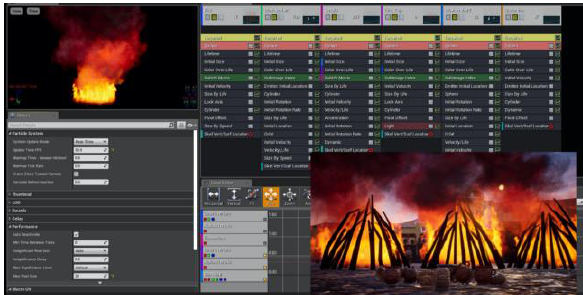
Figure. 3. Process of creating particles for the bonfires where more than 12,000 Maya idols were destroyed during the Great Auto de fe of 1554. Unreal